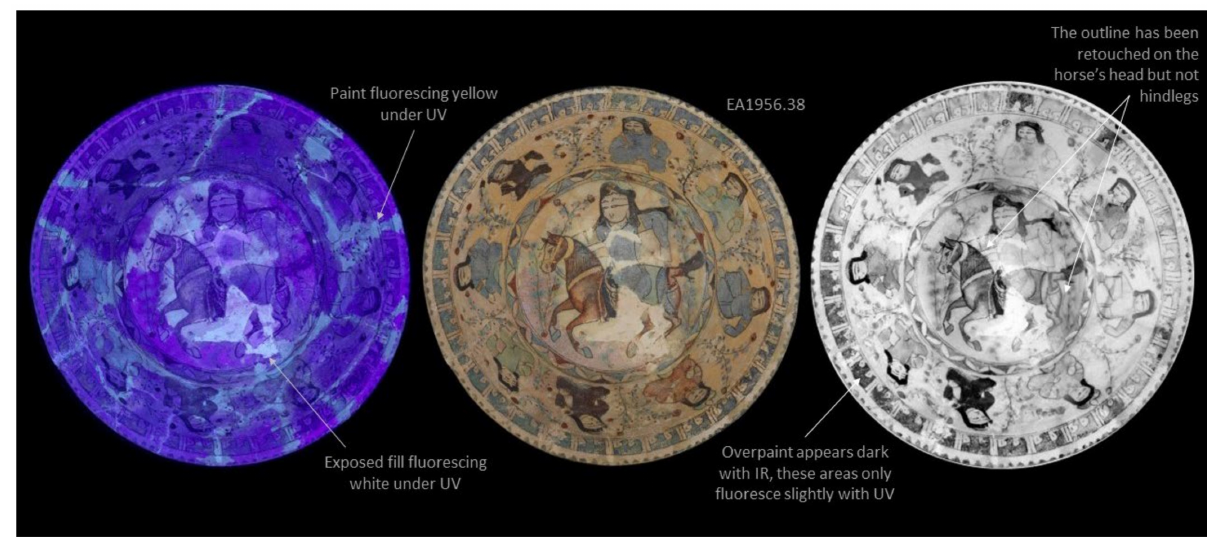
Figure 2. Results of digital photography under ultraviolet light (UV) left, standard visible light centre, and infrared reflectography (IR) on the right for EA.1956.38.